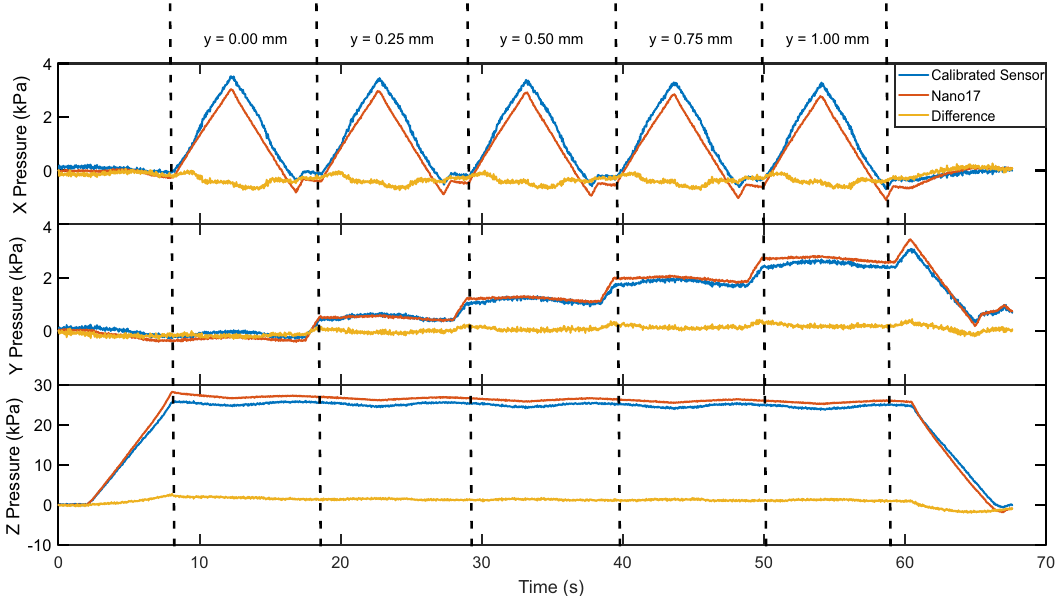
Figure 8. Response of the splint sensor prototype vs. Nano17, with load variation in three